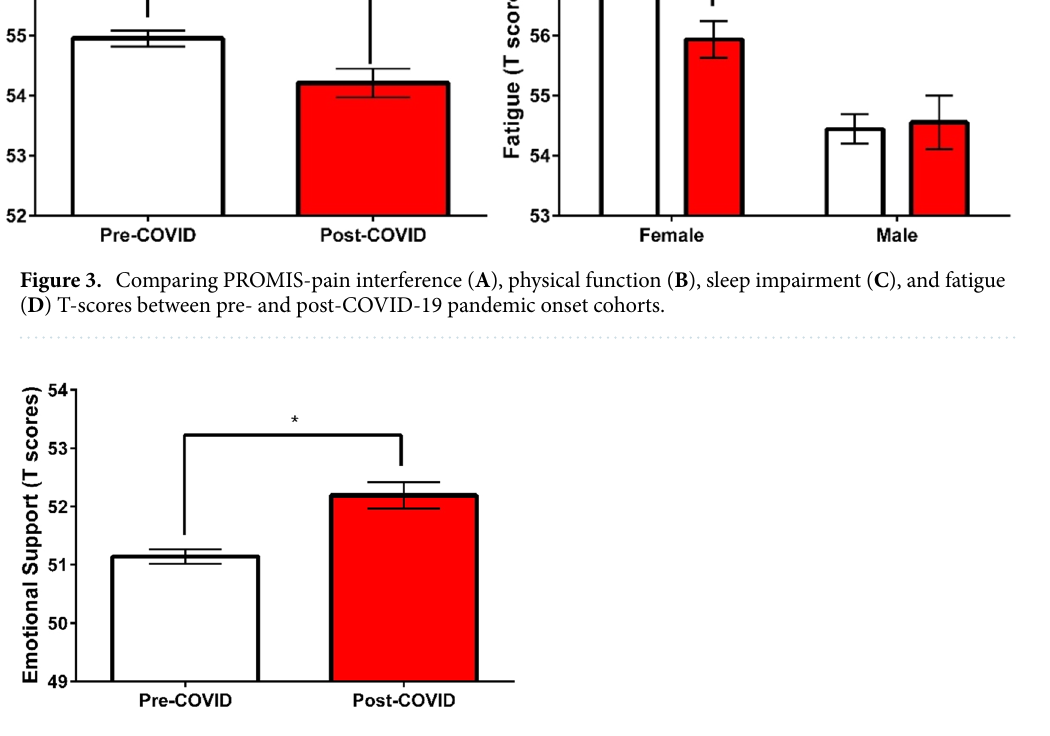
Figure 4. Comparing the PROMIS-emotional support T-scores between the pre- and post-COVID-19